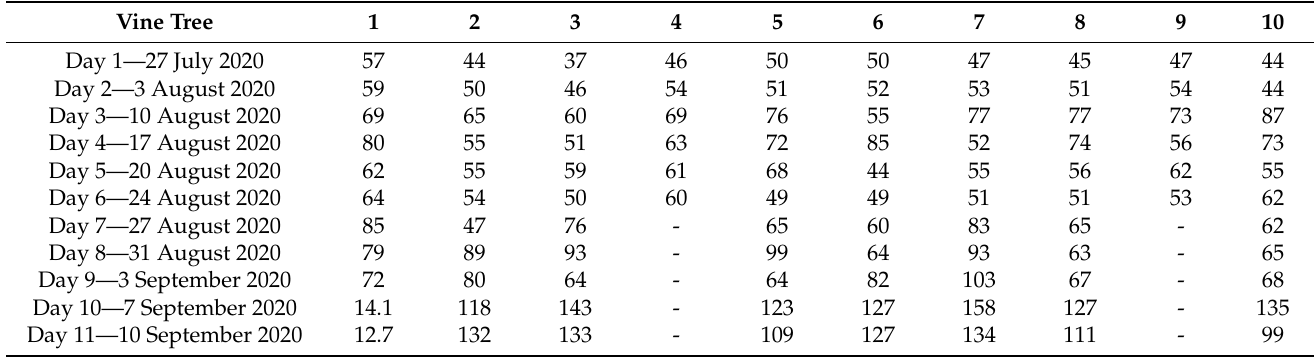
Table 2. Sampling dates. Weights (gr) of collected samples for 10 vines for 11 sampling dates. Vine Tree